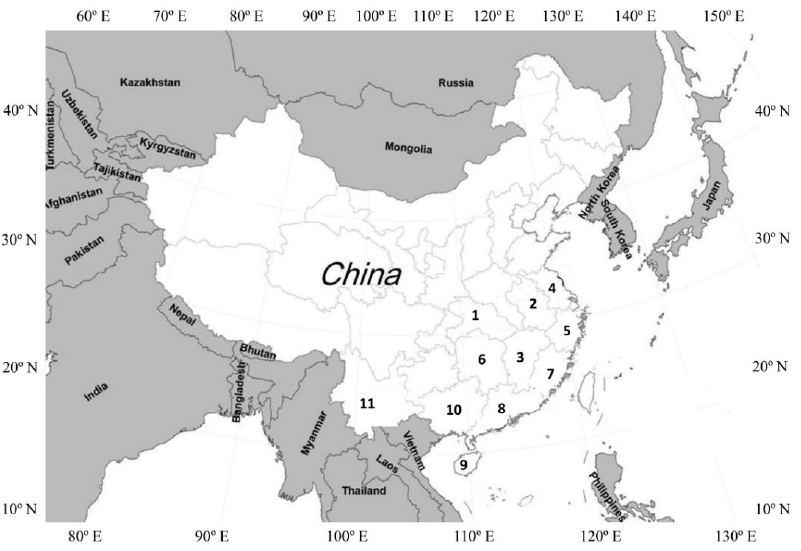
Figure 1. Field sites in China from which S. litura samples were collected; each number in the map represents each site. Table 1. Detailed information on collected S. litura field populations. Population Map Ref. No.